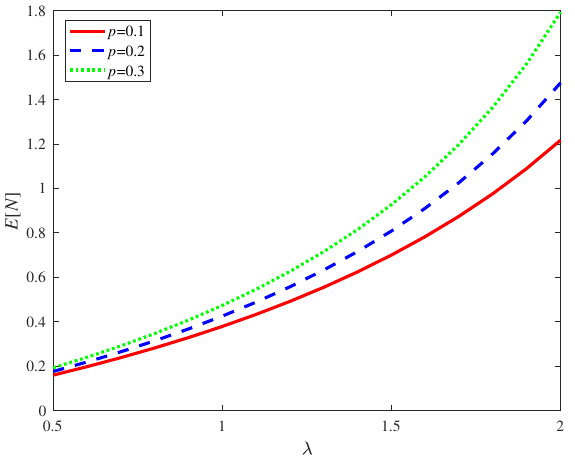
Figure 3. Relation between E [ N ] and λ